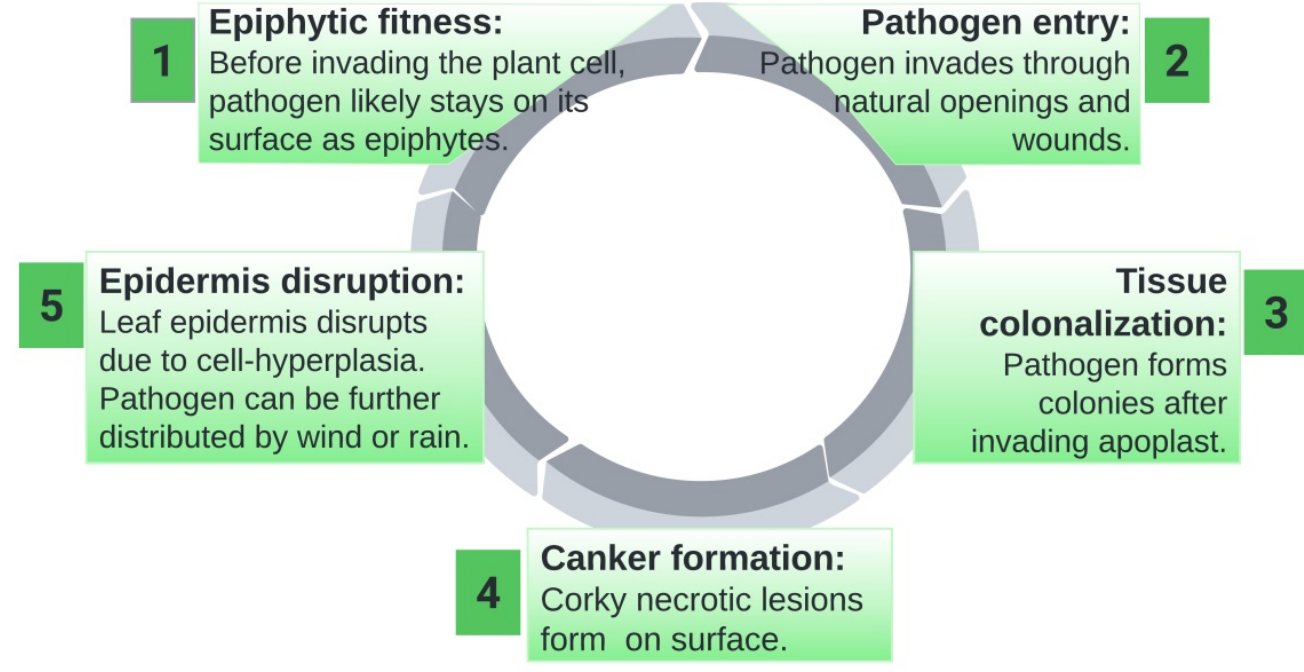
Figure 1. Disease Cycle of Citrus Canker.